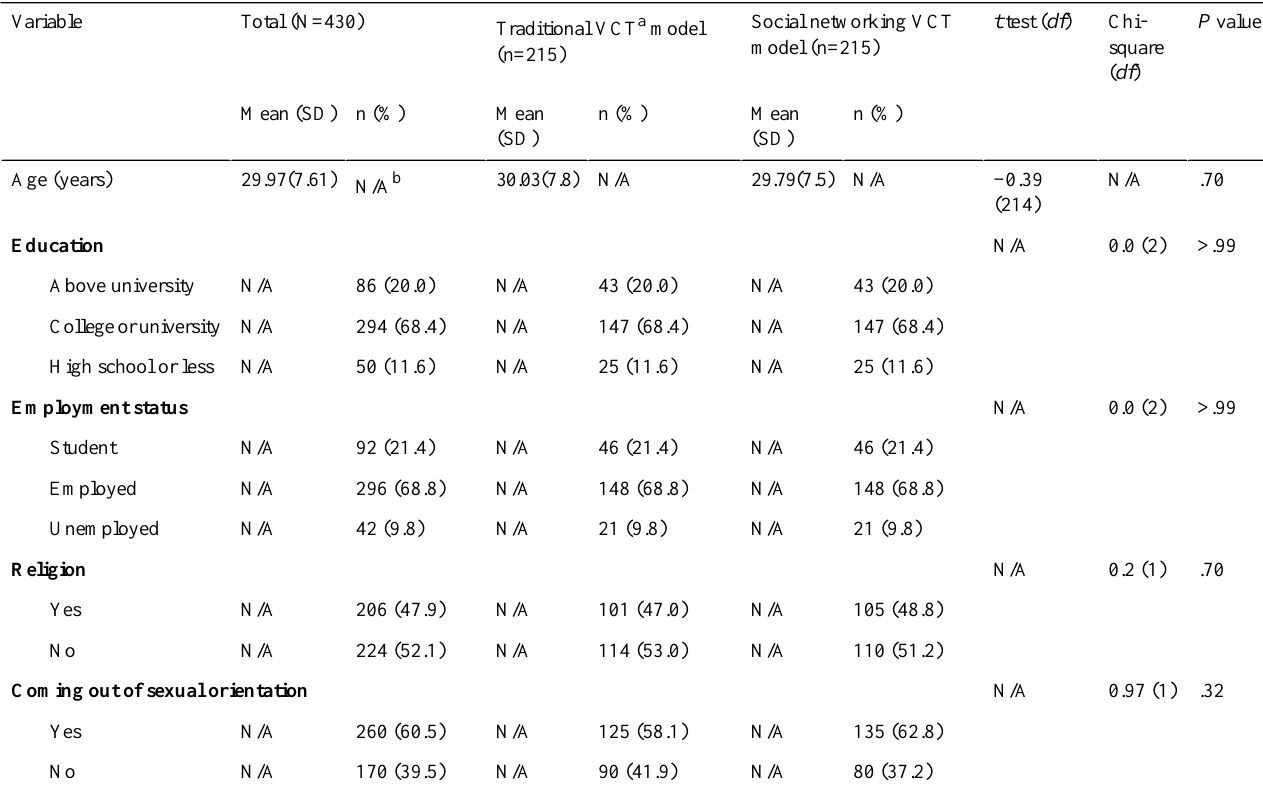
Table 2. The comparison of the characteristics of men who have sex with men between 2 voluntary counseling and testing models.